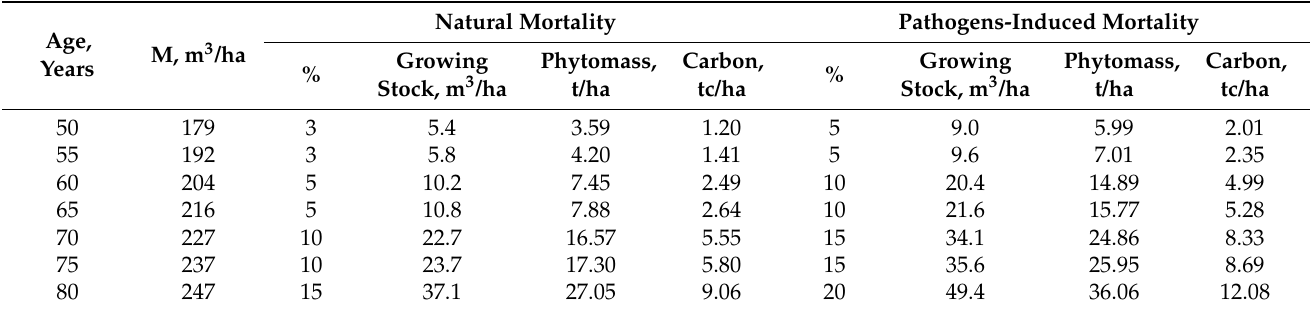
Table 3. The values of natural and pathogenic loss of biomass and carbon in the aspen